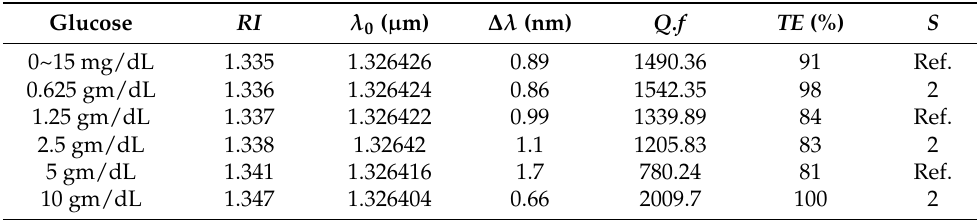
Table 3. Parameters of refractive index, quality factor, sensitivity, as well as resonant wavelength for different values of glucose concentration in human urine. Glucose RI